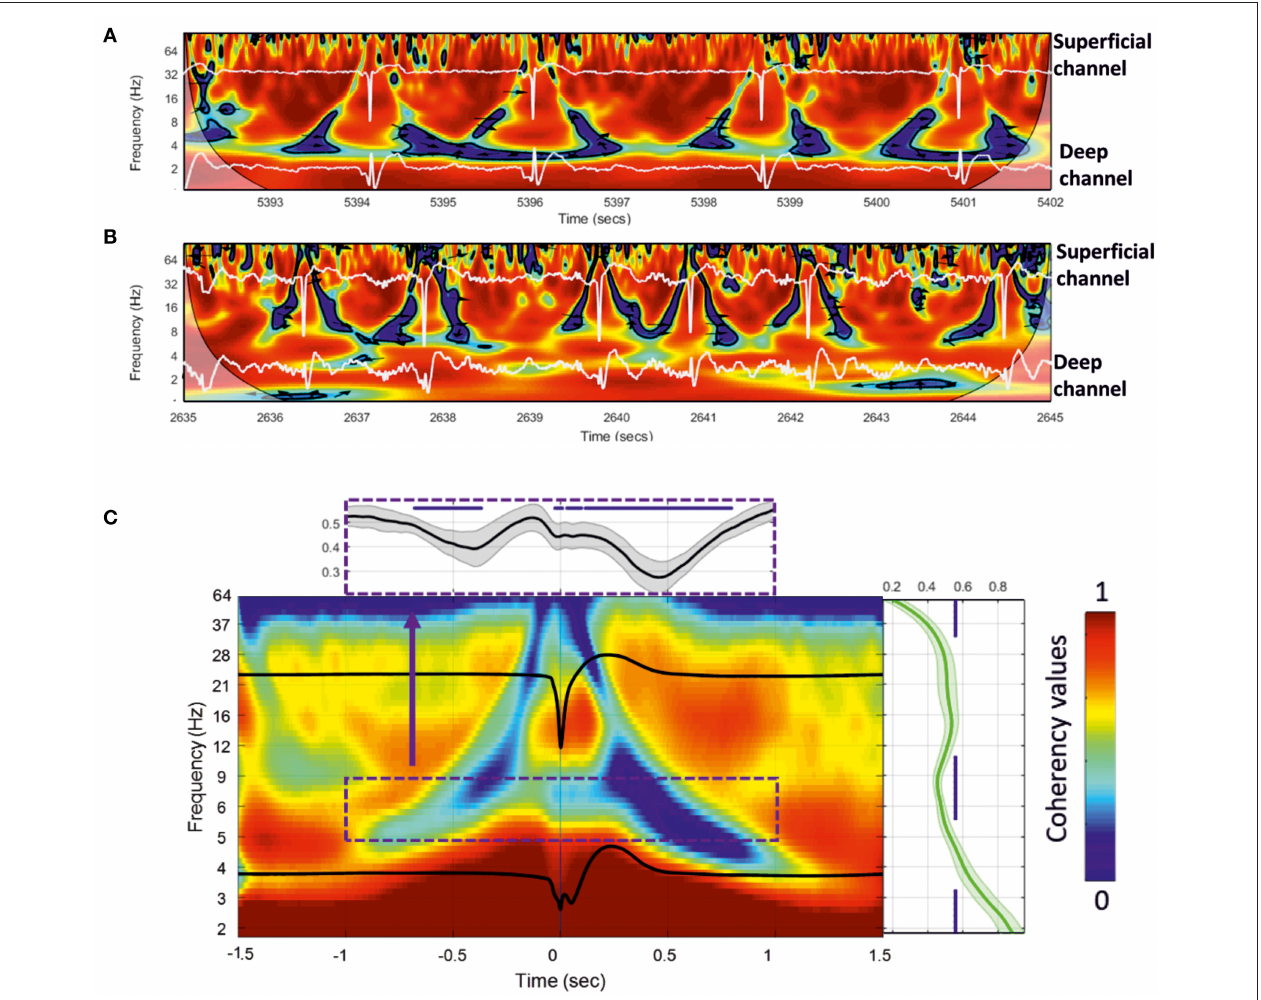
FIGURE 8 | (A,B) Wavelet coherence analysis plot applied to the superficial and deeper channels of the MLE for a 10-s window for two rats. Red represents high coherency and blue low coherency between the superficial and deeper channels. Deep and superficial channels are over-plotted in white in each figure. The significant low coherency values, calculated by the Montecarlo method ( p < 0.05), are shown inside each contour plot (in black). (C) Grand-average of 18 rats for 200 extracted wavelet windows aligned to T0 of 3,600 IISs. The subplots show the mean and standard deviation of the coherency values for all rats. Right: mean coherency values over the frequency axis. Top: mean coherency values over the time